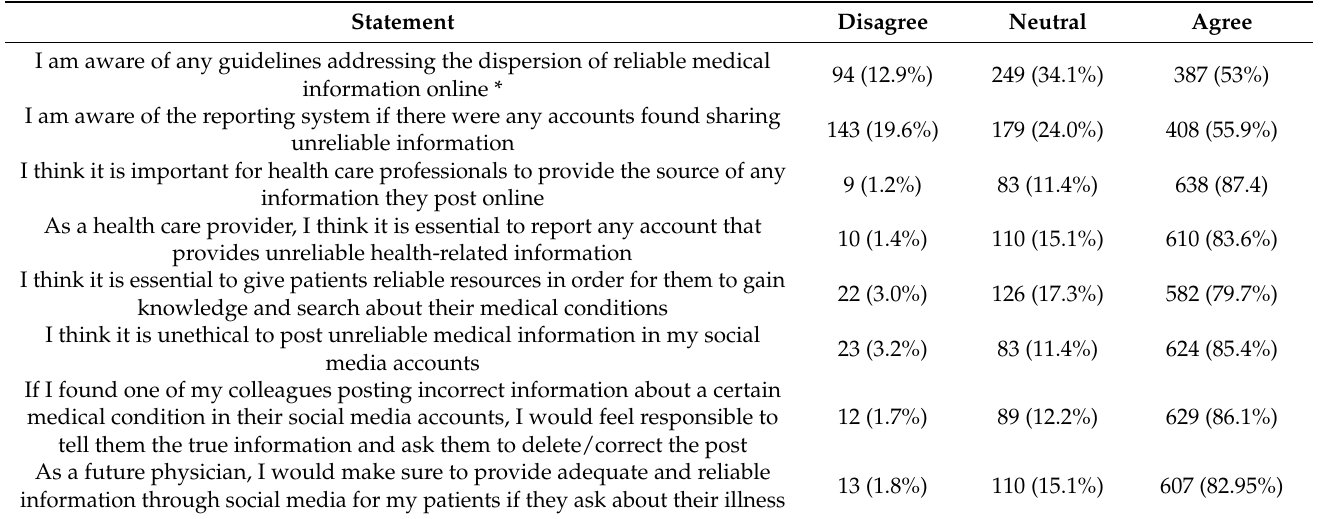
Table 3. Medical students’ view on the reliability of health information shared on social media (n = 730).